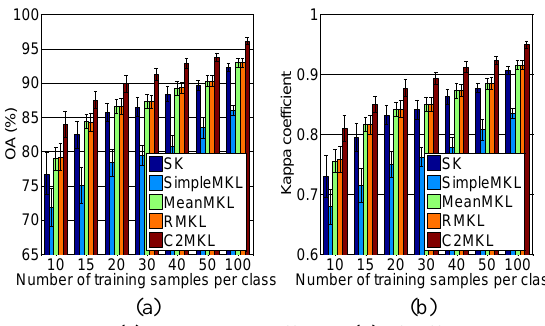
Figure 8. OA (a) and Kappa coefficient (b) of different methods on Recology data set.